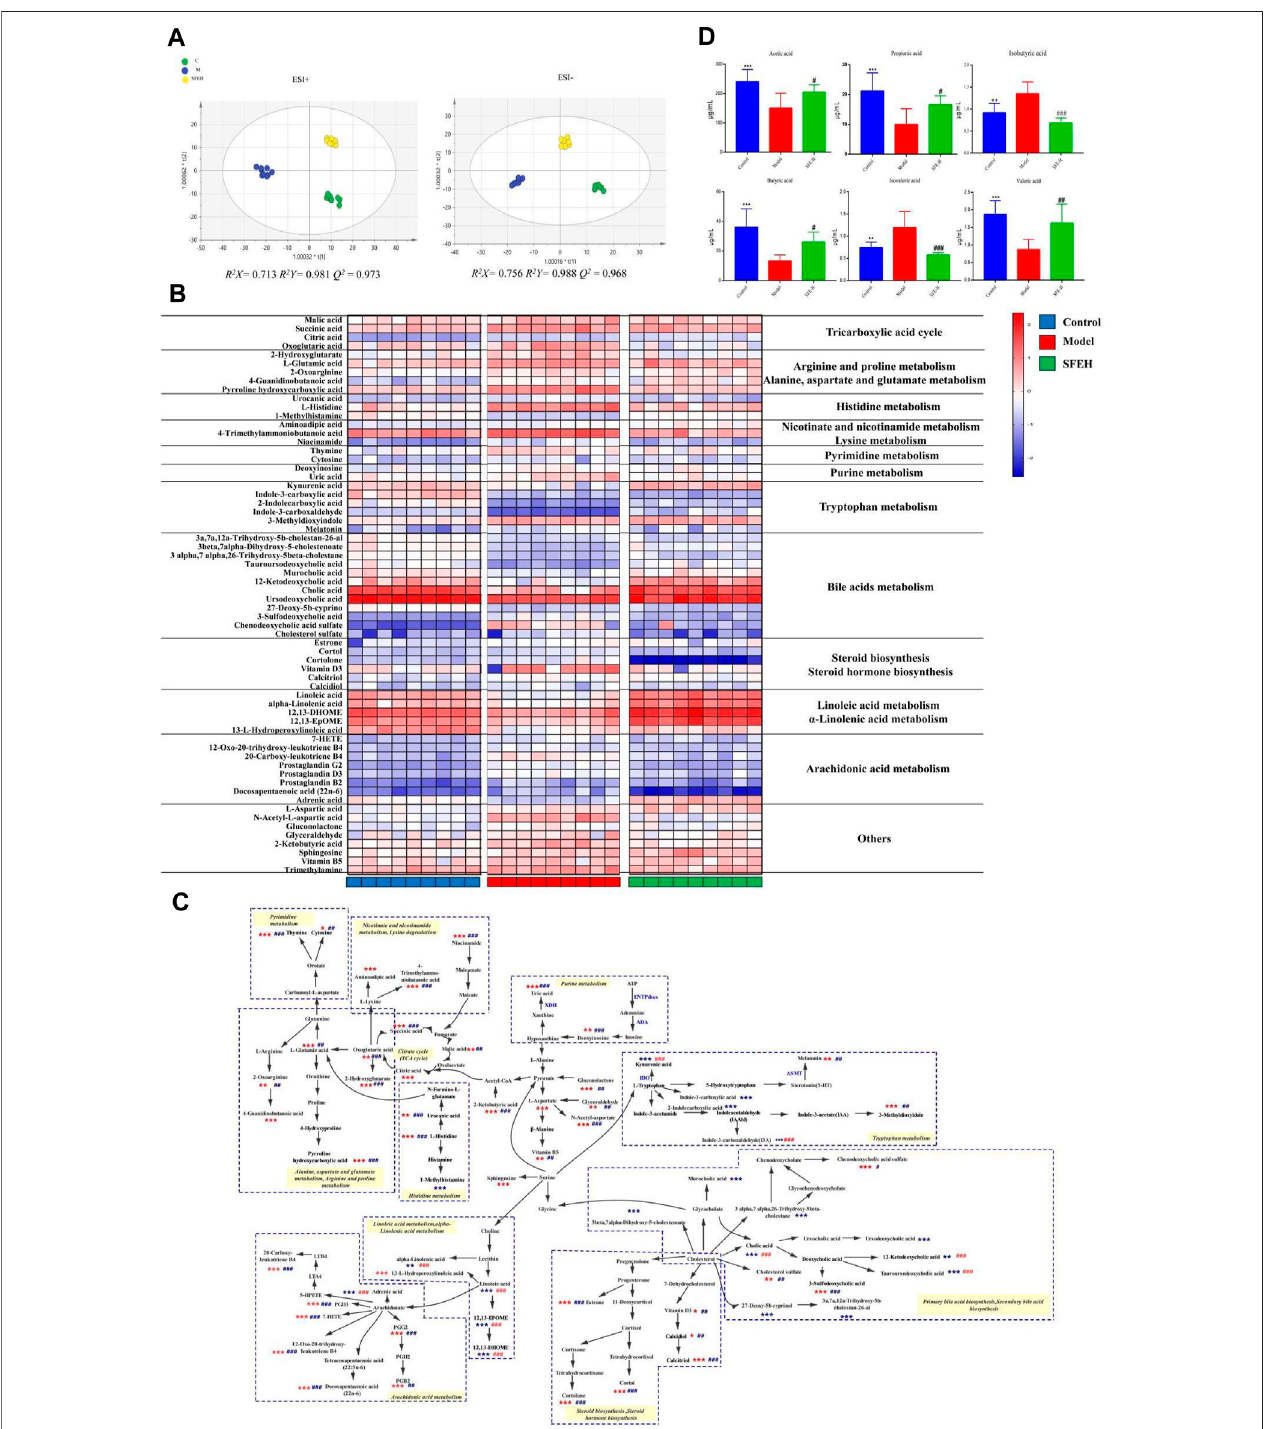
FIGURE 4 | SFE reversed DSS-induced abnormal metabolism. (A) OPLS-DA score of the control, model, and SFE-H groups and QC in positive and negative modes, respectively. (B) HeatMaps of the differential metabolites that were altered by DSS feeding and SFE treatment. (C) Metabolic pathway network, the signi fi cant labels with blue color represent that the metabolite is downregulated, and those with red color represent that the metabolite is upregulated. (D) The concentration of SCFAs in the intestinal contents of the control, model, and SFE-H groups. * means that the control group compared with the model group is signi fi cant; # means that the model group compared with the administrated group is signi fi cant; *, #means p < 0.05; **, ## means p < 0.01; ***, ### means p < 0.001. C, M, SFE-H, and QC represent the control, model, SFE-H, and quality control groups, respectively.